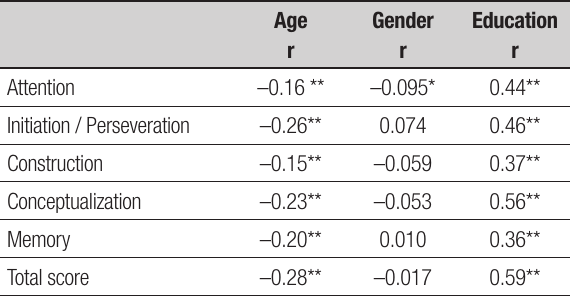
Table 2. Correlations of DRS subscales and total score with demographic